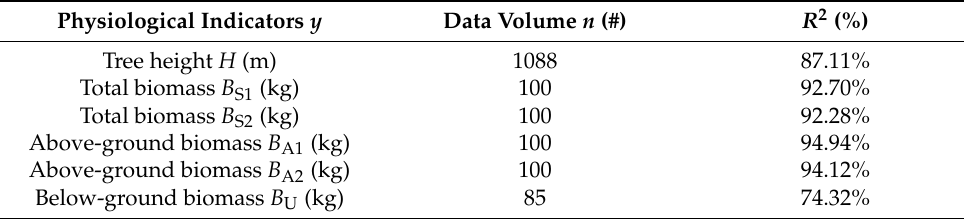
Table 2. Goodness of fit ( R 2 ) of tree growth equations.